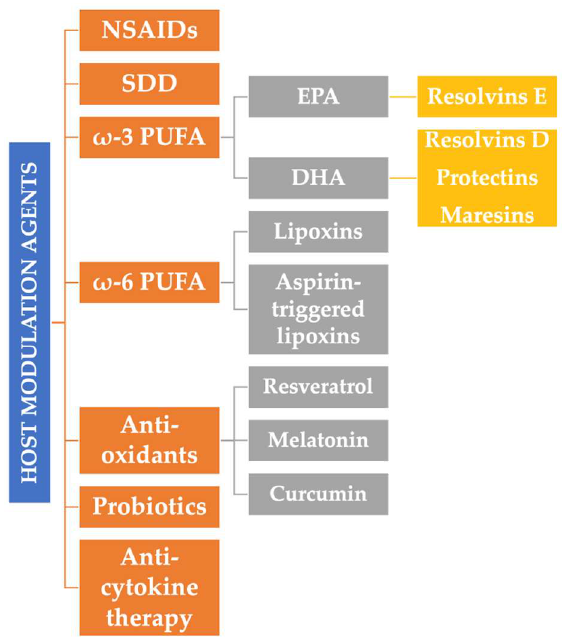
Figure 3. The main classes of substances used in the modulation therapy. NSAIDs: non-steroidal anti-inflammatory drugs; SDD: sub-antimicrobial doses of doxycycline; ω-3/6 PUFA: omega 3/6 polyunsaturated fatty acids; EPA: eicosapentaenoic acid; DHA: docosahexaenoic acid.